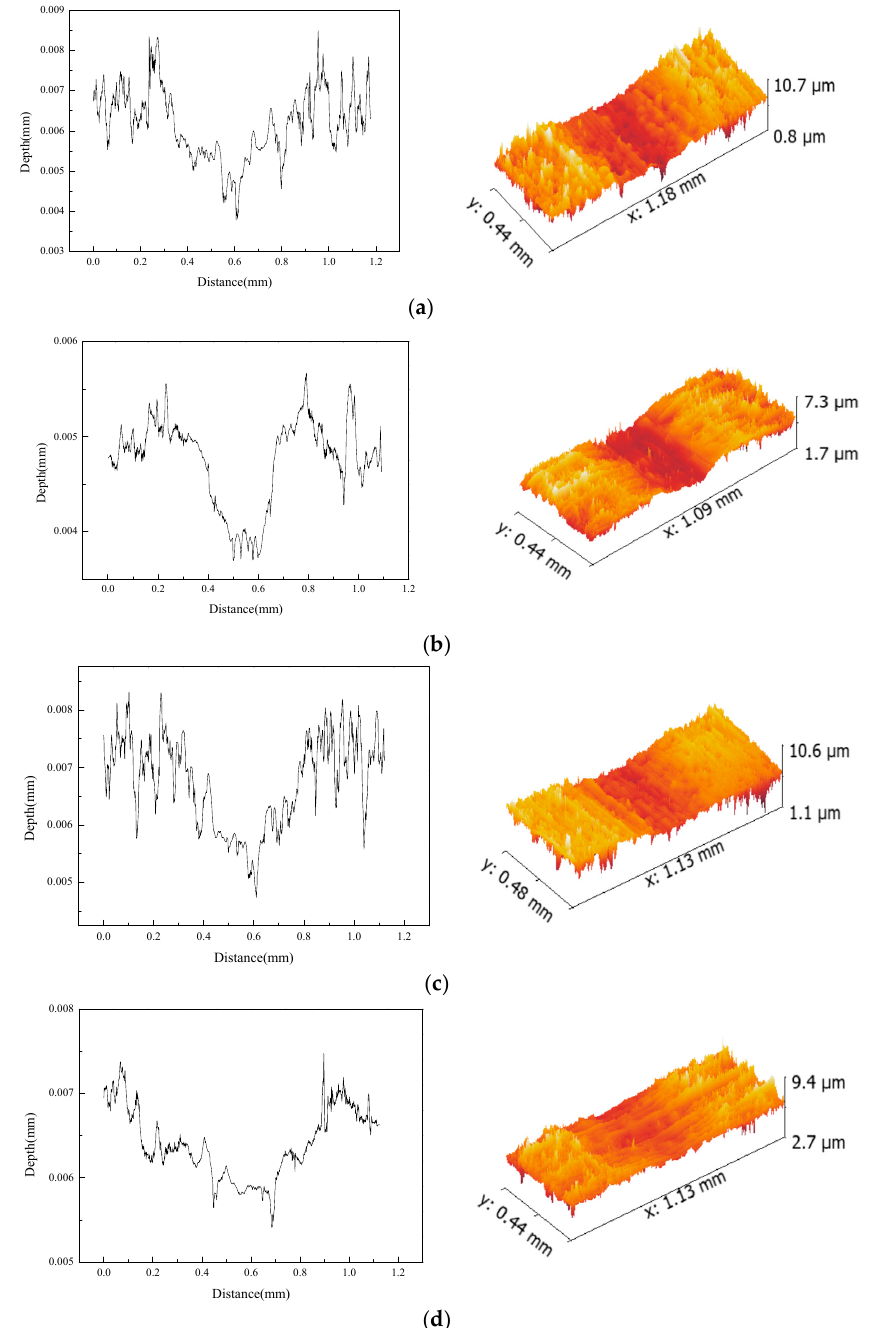
Figure 4. 3-D morphologies and section profiles of the wear tracks of PEEK/PTFE composites: ( a ) PEEK/PTFE; ( b ) PEEK/PTFE + 30% CFs; ( c ) PEEK/PTFE + 20% CFs + 10% Gr; ( d ) PEEK/PTFE + 10% CFs + 20% Gr.